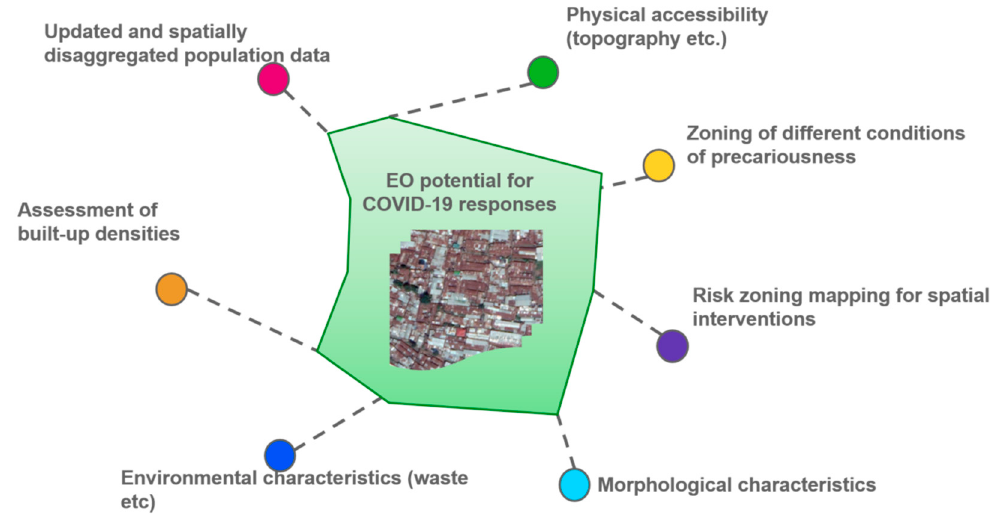
Figure 11. Summarizing the potential of Earth observation (EO) data for the case of Salvador, Brazil.